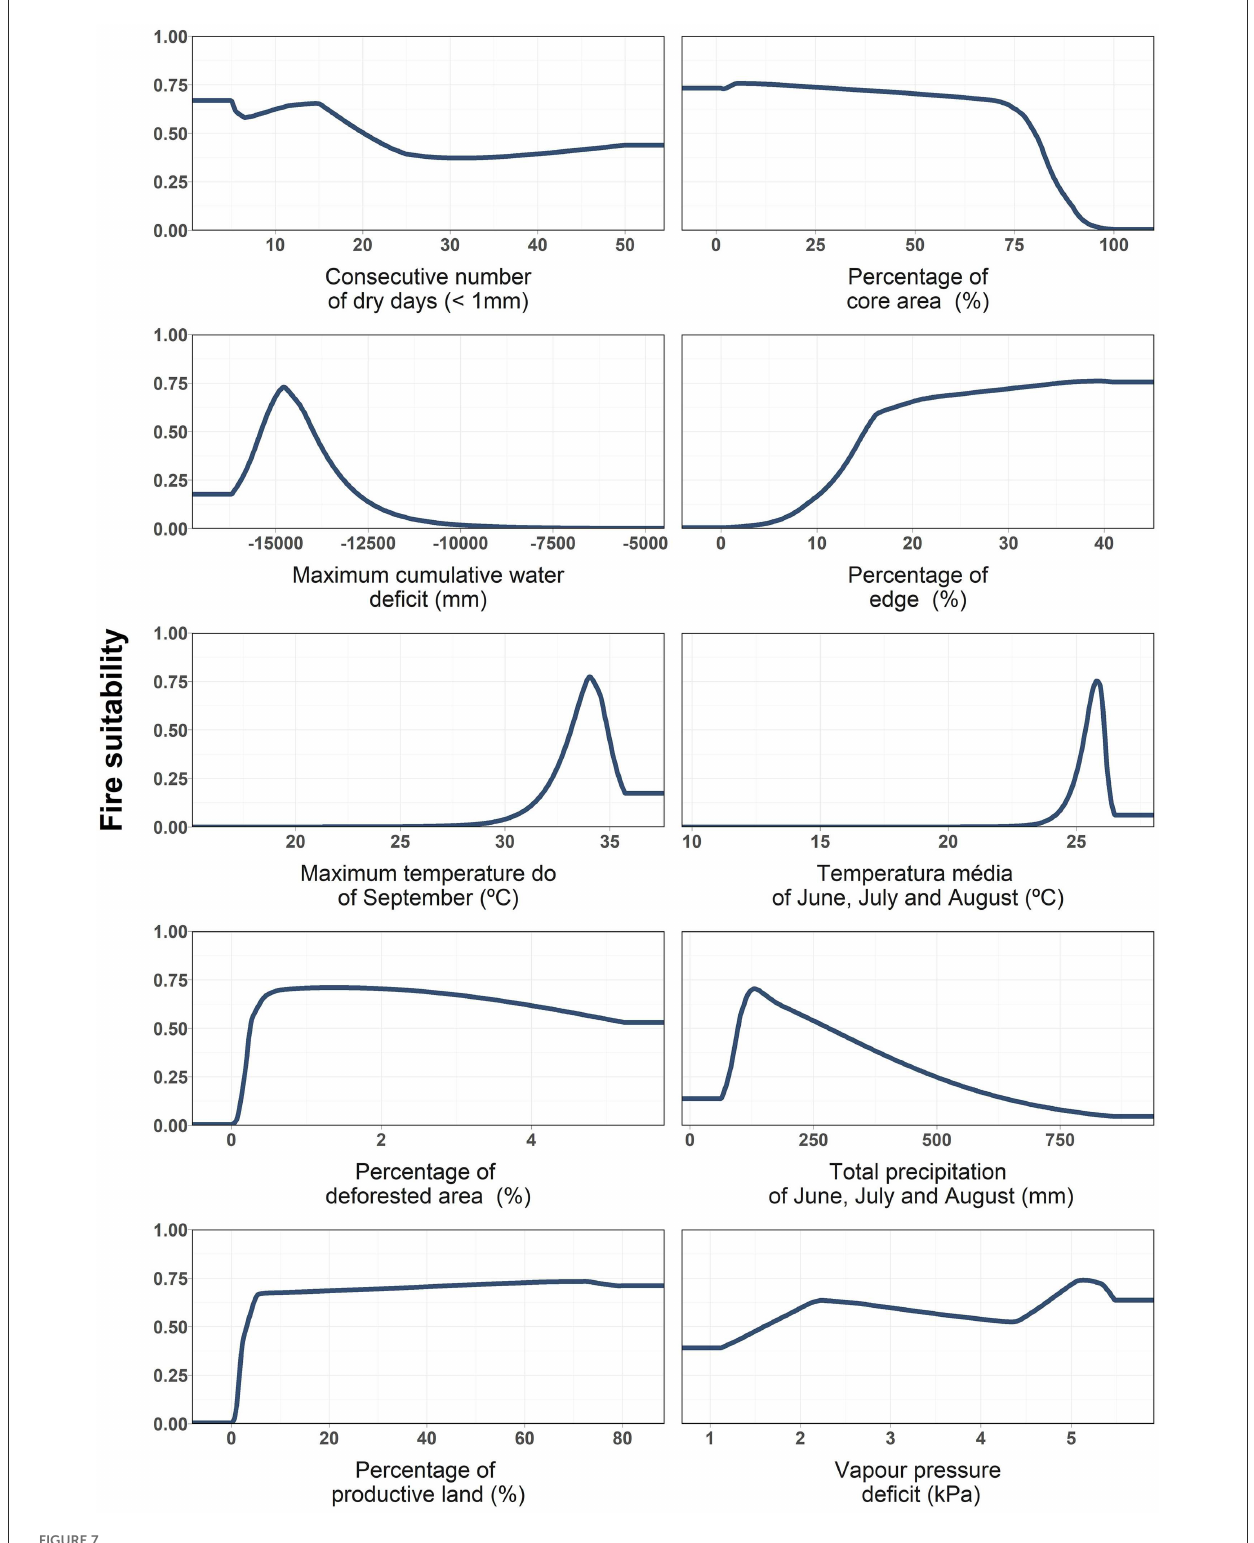
FIGURE7 Response curve of each predictor variable.